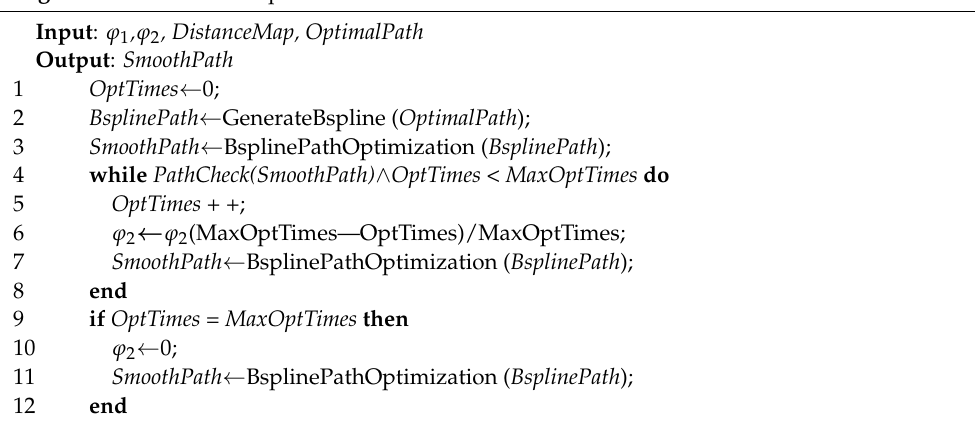
Algorithm 3 . Smooth the